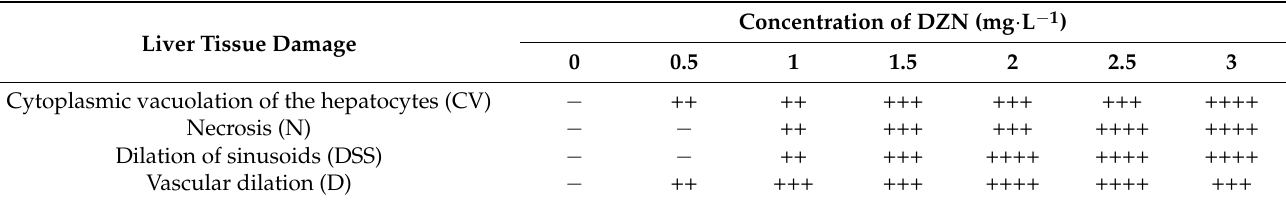
Table 2. Liver lesions in premature grass carp ( Ctenopharyngodon idella ) after exposure to six different concentrations of diazinon (DZN).